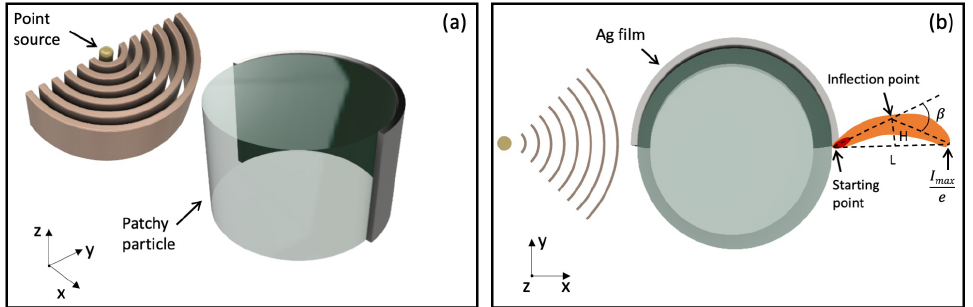
Figure 1. ( a ) Schematic drawing of a patchy microcylinder under point-source illumination. ( b ) The points used to define the properties of the generated